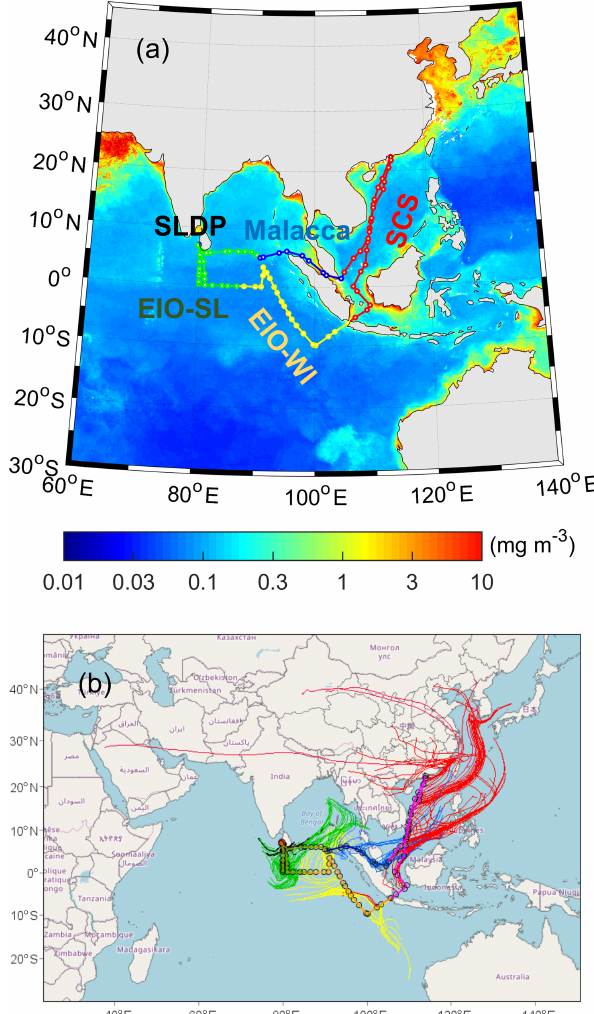
Figure 1. (a) Cruise tracks used for aerosol collection in the South China Sea (SCS) and the eastern Indian Ocean (EIO) from 10 March to 26 April 2015. The red line is located in the SCS region, the yellow line is in the eastern Indian Ocean near western Indone- sia (EIO-WI), the green line is in the eastern Indian Ocean near Sri Lanka (EIO-SL), the blue line is in the Malacca region, and the red solid points are the collection positions of the three Sri Lanka docking point (SLDP) samples. The base map (© MAT- LAB) reflects an average composite of Chlorophyll a concentra- tions from March to April 2015 obtained from the NASA web- site: https://modis.gsfc.nasa.gov/data/dataprod/chlora.php (last ac- cess: 3 July 2019). (b) Air mass backward trajectories for the sam- pling days at an arrival height of 100m; the map was produced using © MeteoInfo software. (Please note that the above figure contains disputed